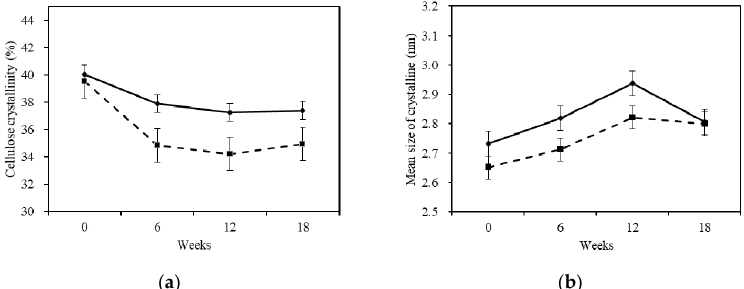
Figure 5. Changes of ( a ) cellulose crystallinity and ( b ) crystalline mean size before and after degradation. The continuous and discontinuous lines in the figure caption indicates sapwood and heartwood. The error bar is according to a confidence interval of 95%.